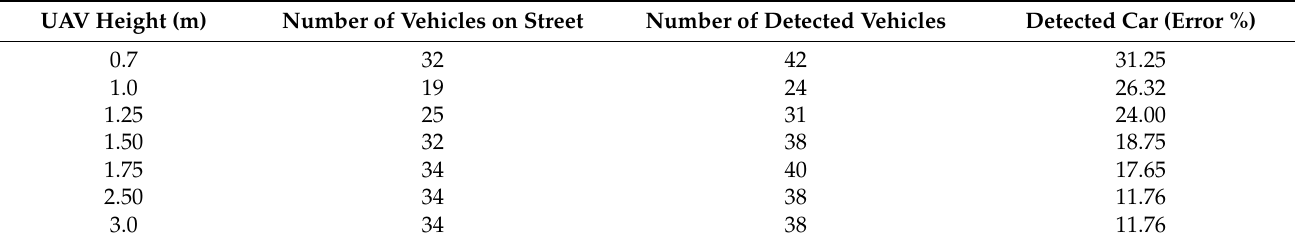
Table 7. Vehicle Detection Accuracy on the UAV Height Variation.